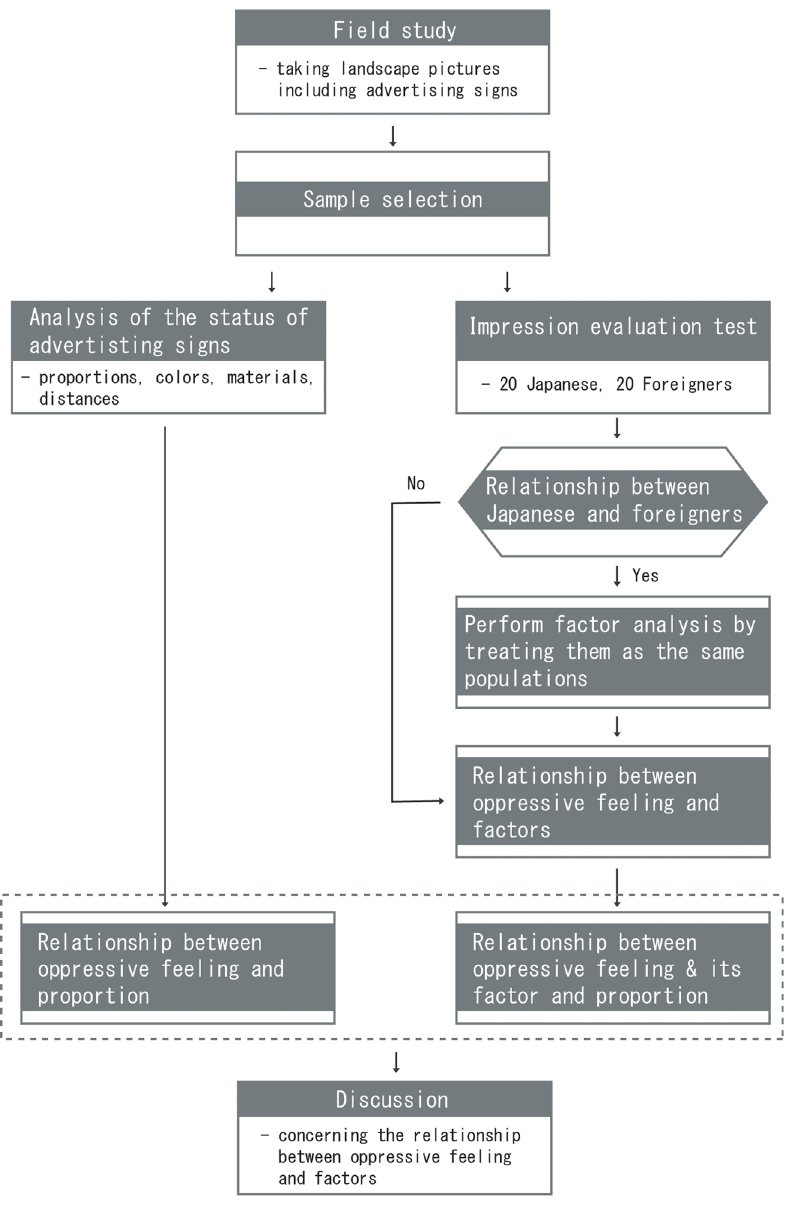
Figure 1. Research flow.